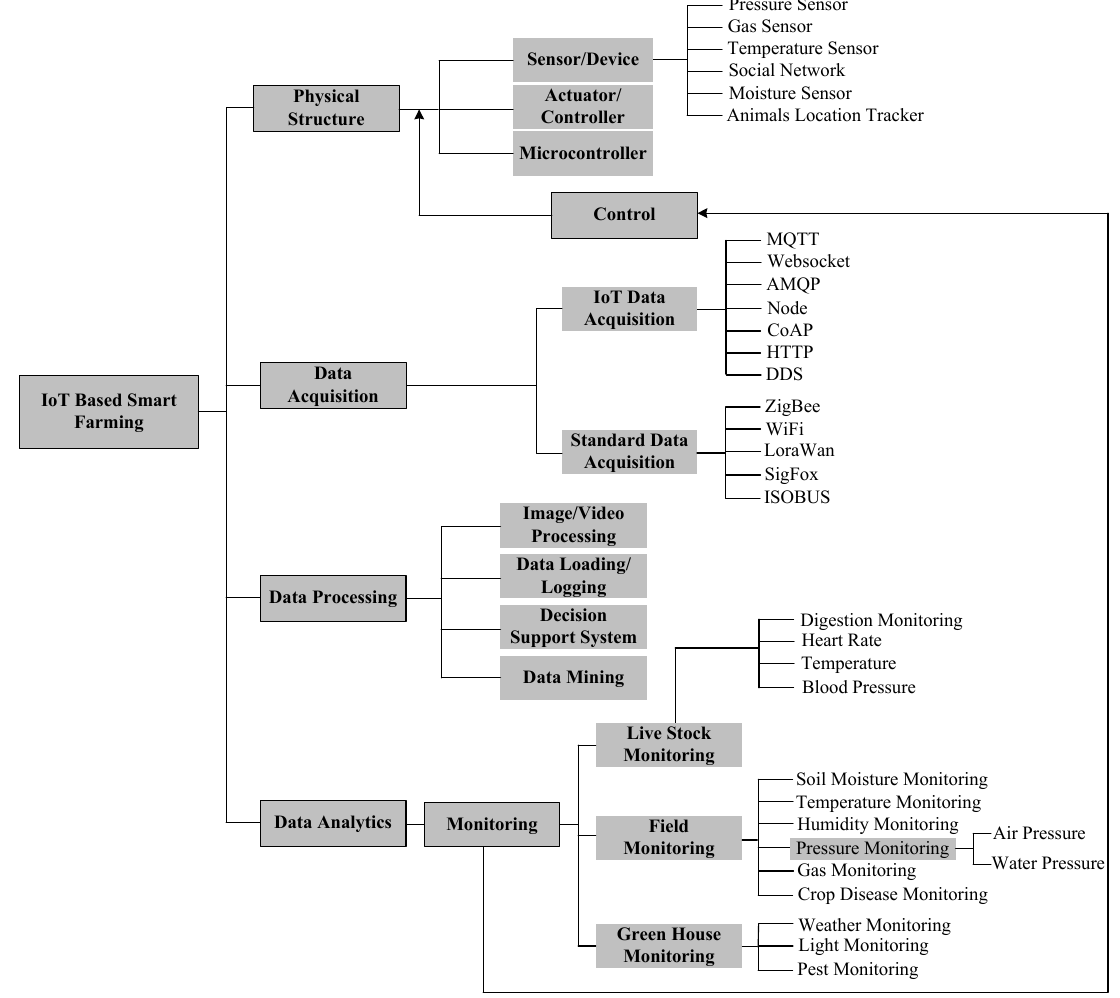
Figure 14. Significant elements of SF based on IoT.